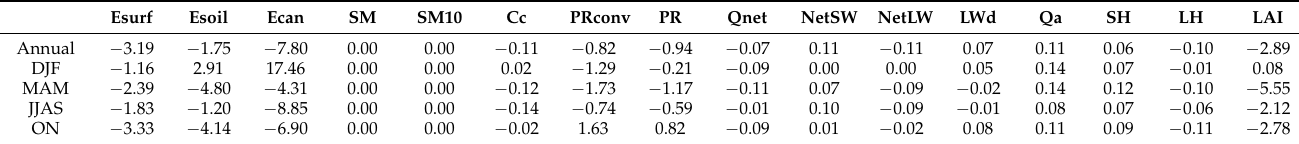
Table 1. The regression coefficients of the linear relationships described in Figure